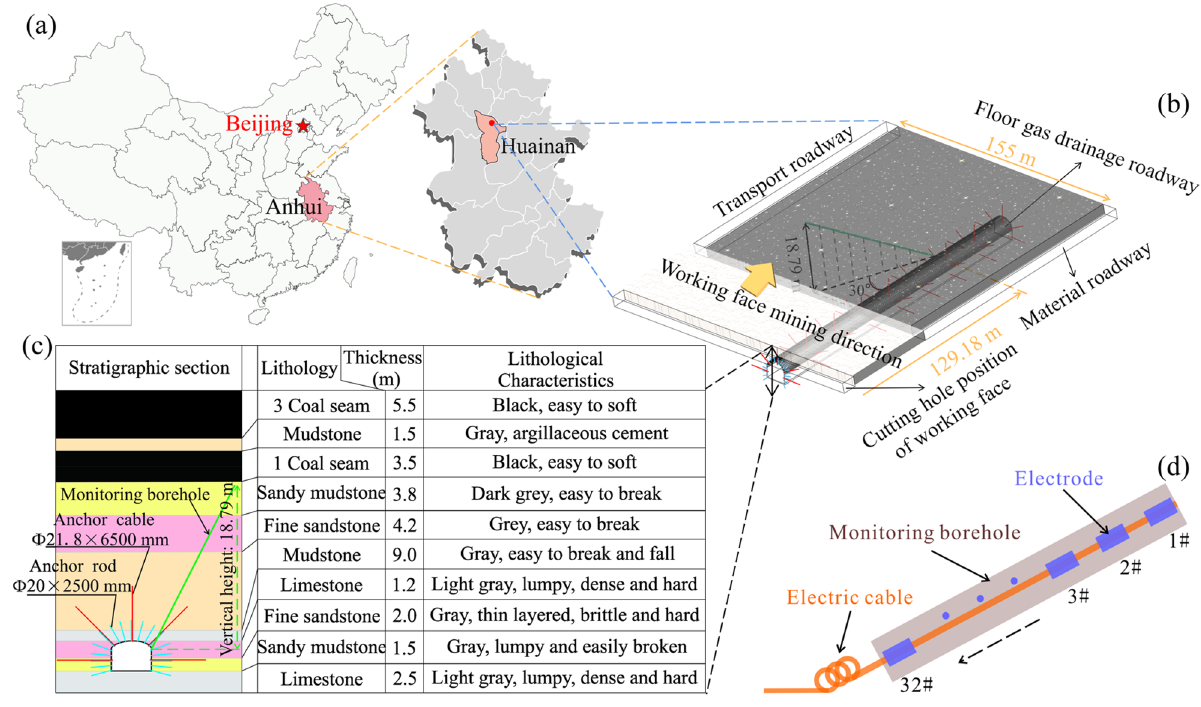
Figure 4. Location of the research area and cross-section of the strata structure.